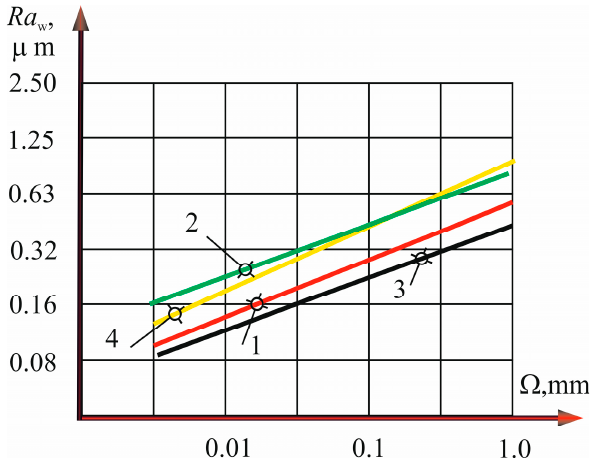
Figure 12. The dependence of the optimal values of the preliminary roughness of the surface on the allowance for processing when grinding rolls with dimensions 𝑑 × 𝑙 = 500 × 1200 mm to obtain surface roughness: 1: 𝑅𝑎 = 0.04– 0.02 µm (in a single operation); 2:𝑅𝑎 = 0.04– 0.02 µm (in two op- erations); 3: 𝑅𝑎 = 0.02– 0.01 µm (in two operations); 4:𝑅𝑎 = 0.02–0.01 µm (in three